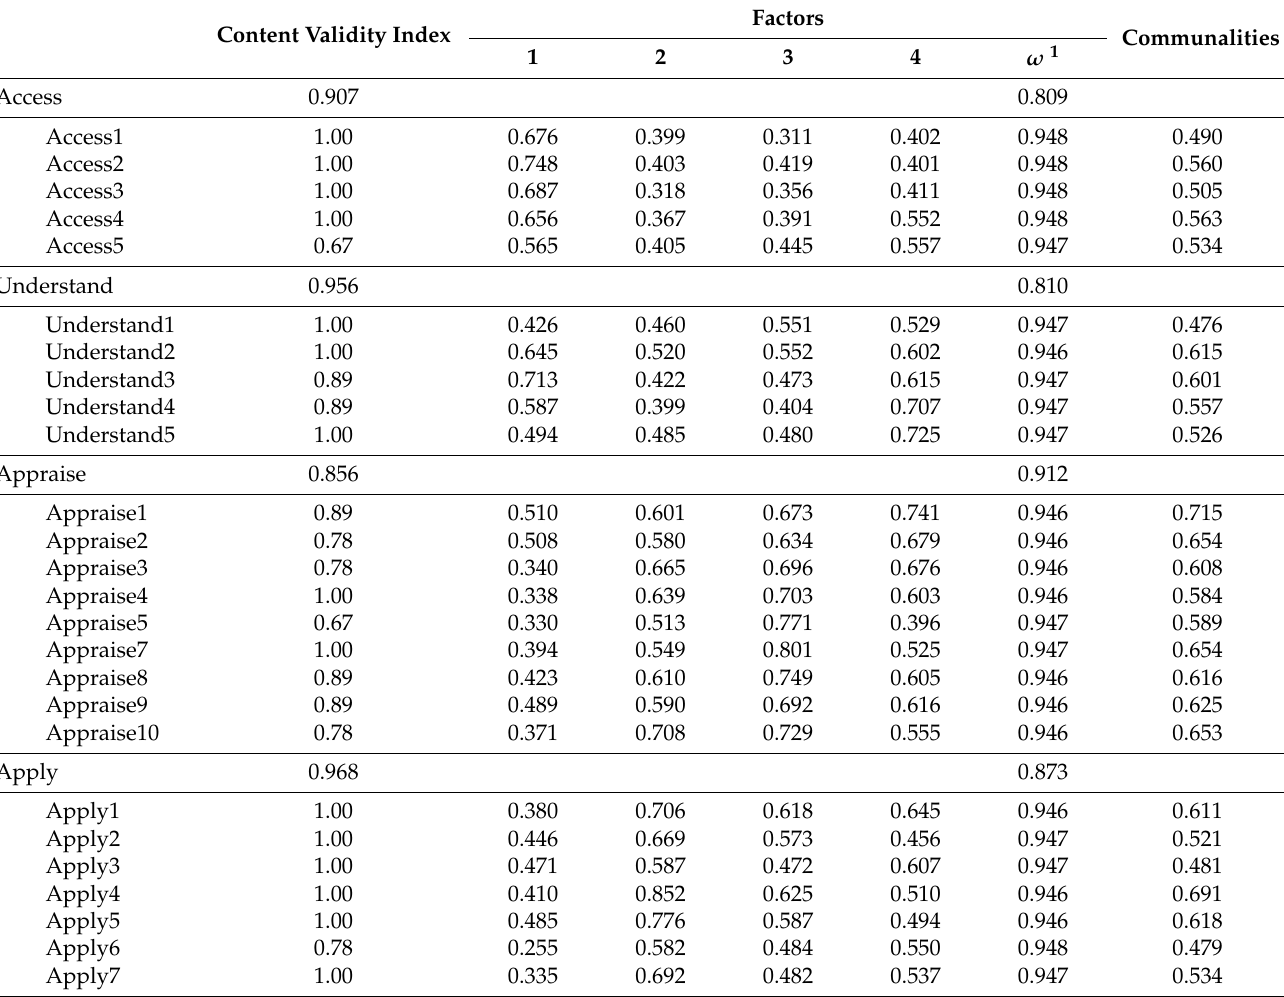
Table 1. Content validity, Exploratory Factor Analysis, and reliability of